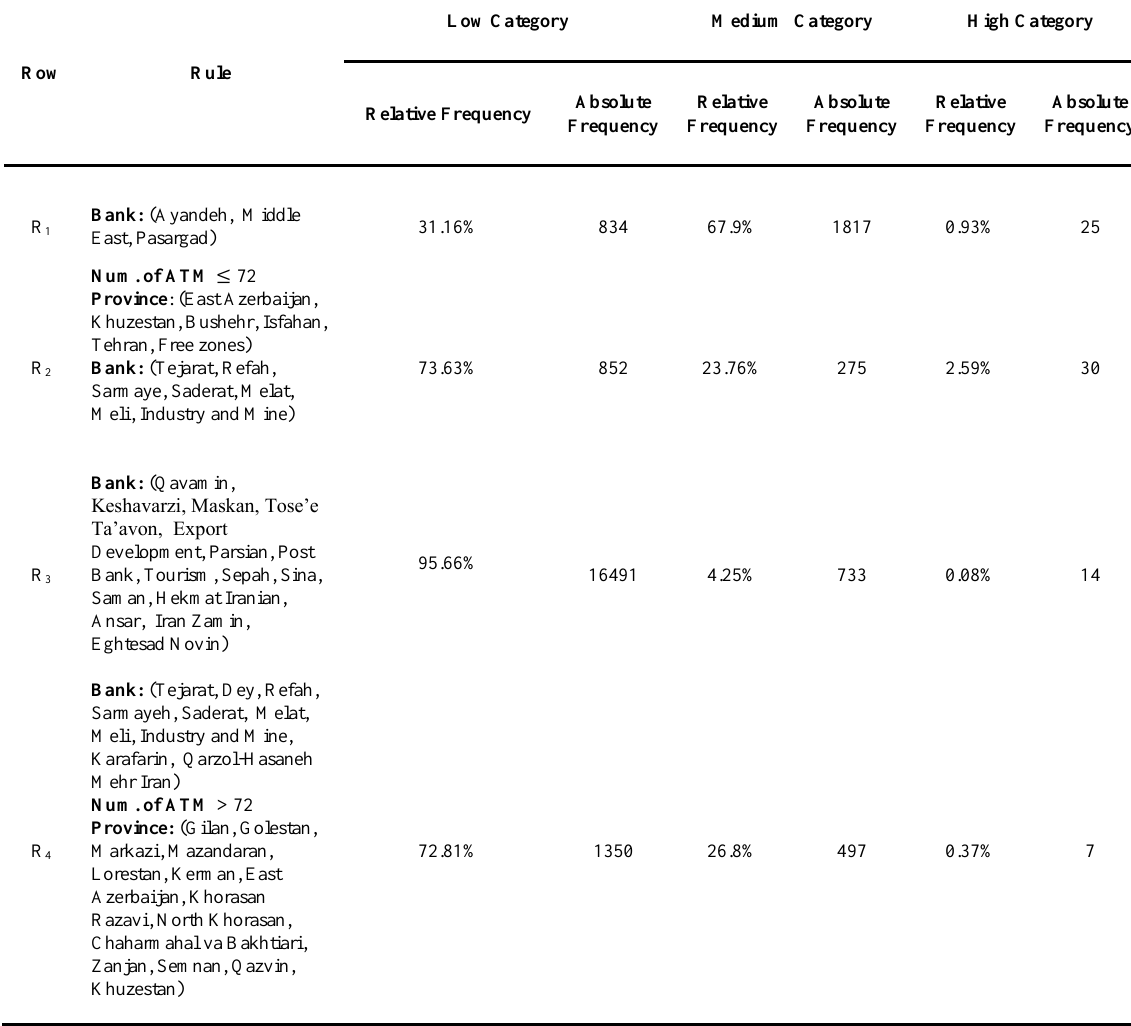
Table 6. Extracted rules of decision tree of ATM transactions regardless of month and year.